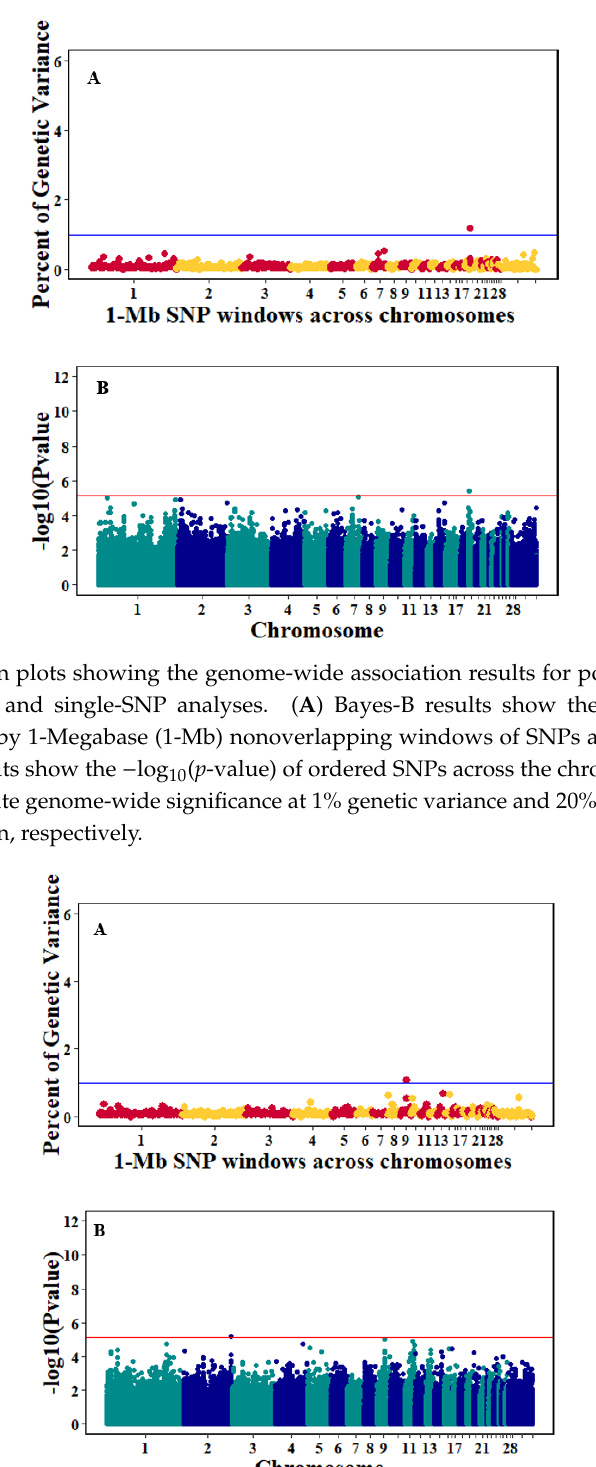
Figure 3. Manhattan plots showing the genome-wide association results for pre-infection growth rate using Bayes-B and single-SNP analyses. ( A ) Bayes-B results show the percent of genetic variance explained by 1-Megabase (1-Mb) non-overlapping window of SNPs across chromosomes. ( B ) Single- SNP results show the − log 10 ( p- value) of ordered SNPs across the chromosomes. The blue and red lines indicate genome-wide significance at 1% genetic variance and 20% genome-wise significance.